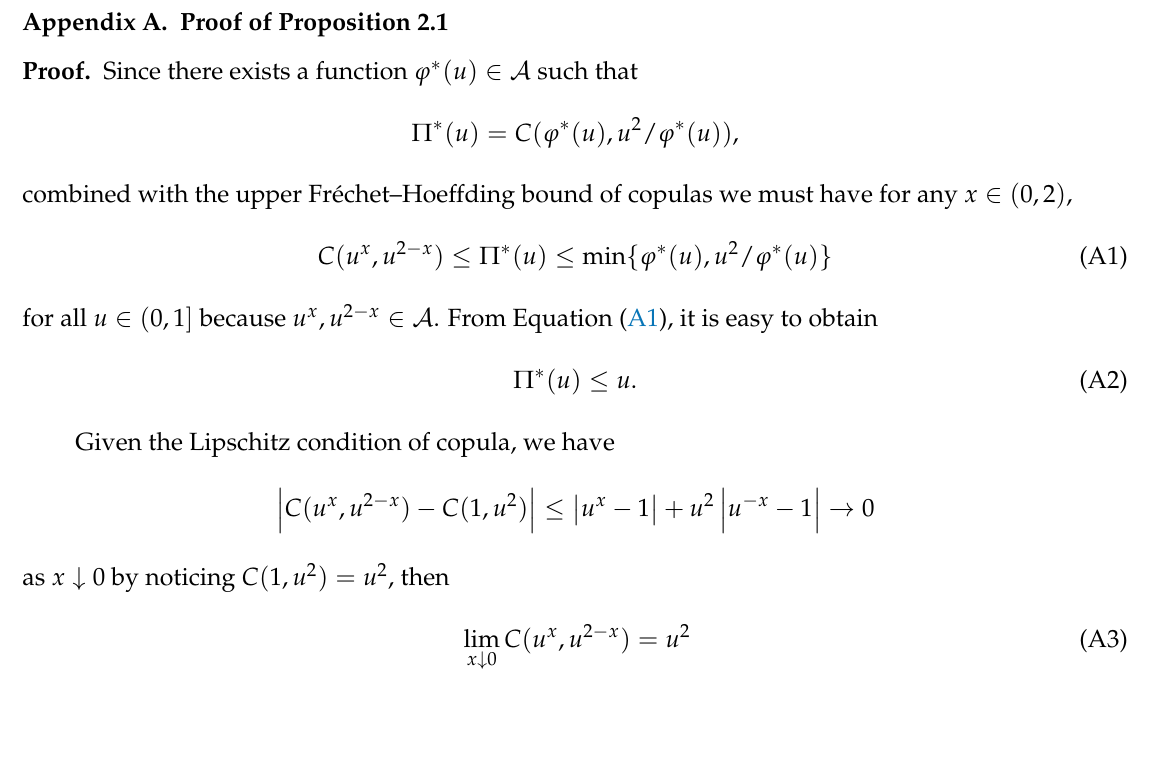
Table S1: 1001 portfolios constructed for all combinations of 4 currencies out of 14 currencies. The portfolio weights obtained by Markowitz minimal variance criteria is given in the bracket. Also, mean returns and accumulative returns are